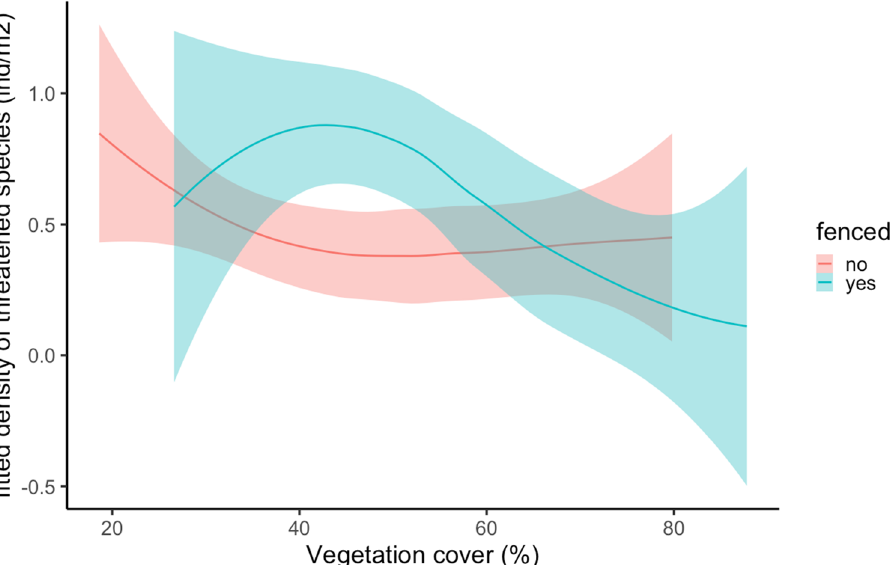
Figure 1. Relationship between vegetation cover (%) and density (individual/m 2 ) of the focal threatened species for fenced (blue) and unfenced (red) habitat patches (fitted values adjusted by linear mixed model for all the species and populations, see Table